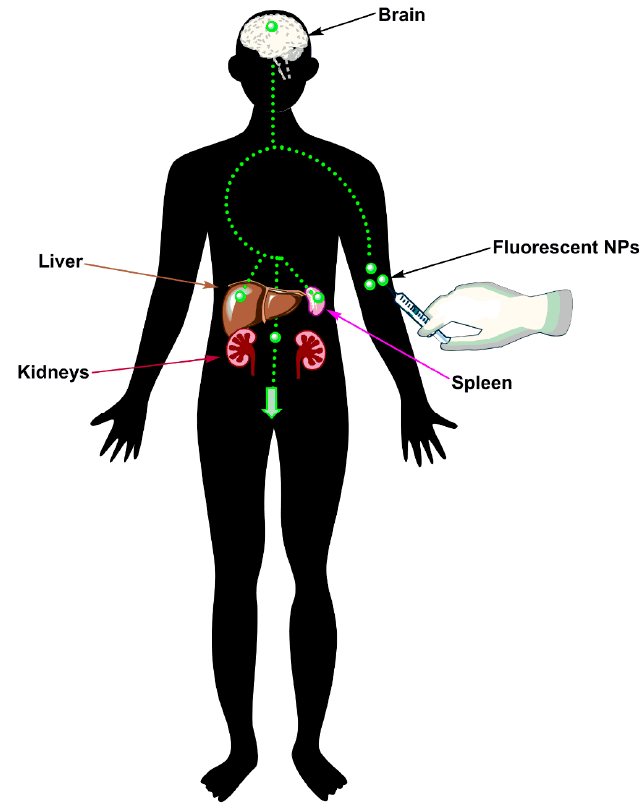
Figure 1. Nanoparticles (NPs) used for diagnosis. Some NPs such as quantum dots can be employed for bio-imaging due to their inherent fluorescent nature and their use as contrasting agents. This helps to track them in vivo and to understand their pharmacokinetics. Although the kidneys serve as a primary route of clearance, the liver and spleen also serve to clear NPs from the